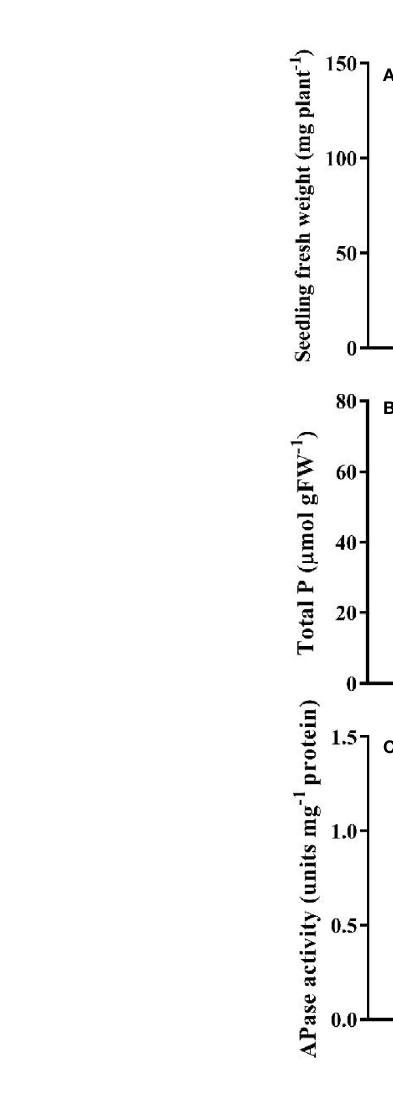
FIGURE 7 | Analyses of AtPAP17 and AtPAP26 overexpressed lines (OE17 and OE26) grown under +Pi (1.25 mM KH 2 PO 4 ) and − Pi (no Pi) conditions. Fresh weight (A) , total P content (B) , and APase activities (C) of 21-day-old Arabidopsis seedlings of Col-0, OE17 and OE26 lines. Each overexpressed line includes four independent transgenic lines. Values are the means ± SE of three biological replicates. Signi fi cant differences are indicated by different letters above the bars ( P <